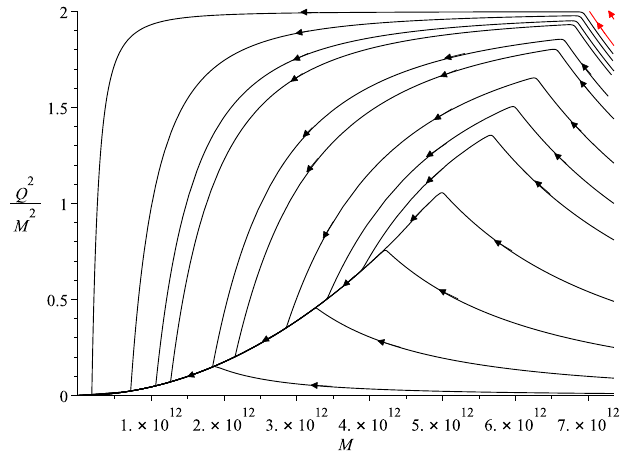
Figure 2 . The evolution of asymptotically (cid:13)at GHS black holes under Hawking evaporation with Hiscock-Weems model, assuming d Q= d t follows eq. (2.6), shows that su(cid:14)ciently massive black holes (in red) appear to evolve towards extremality. The extremality condition is Q 2 =M 2 = 2.